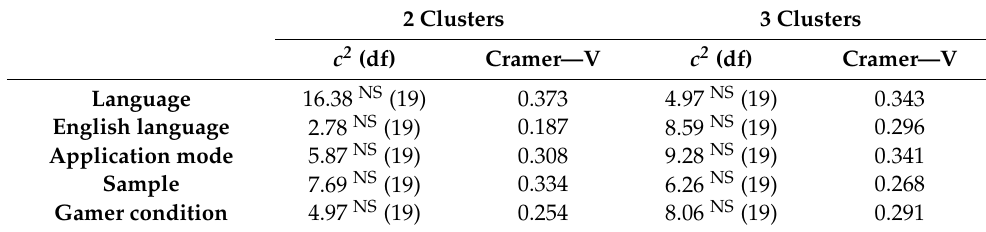
Table 4. IGDS9D: dependence of cluster–covariable